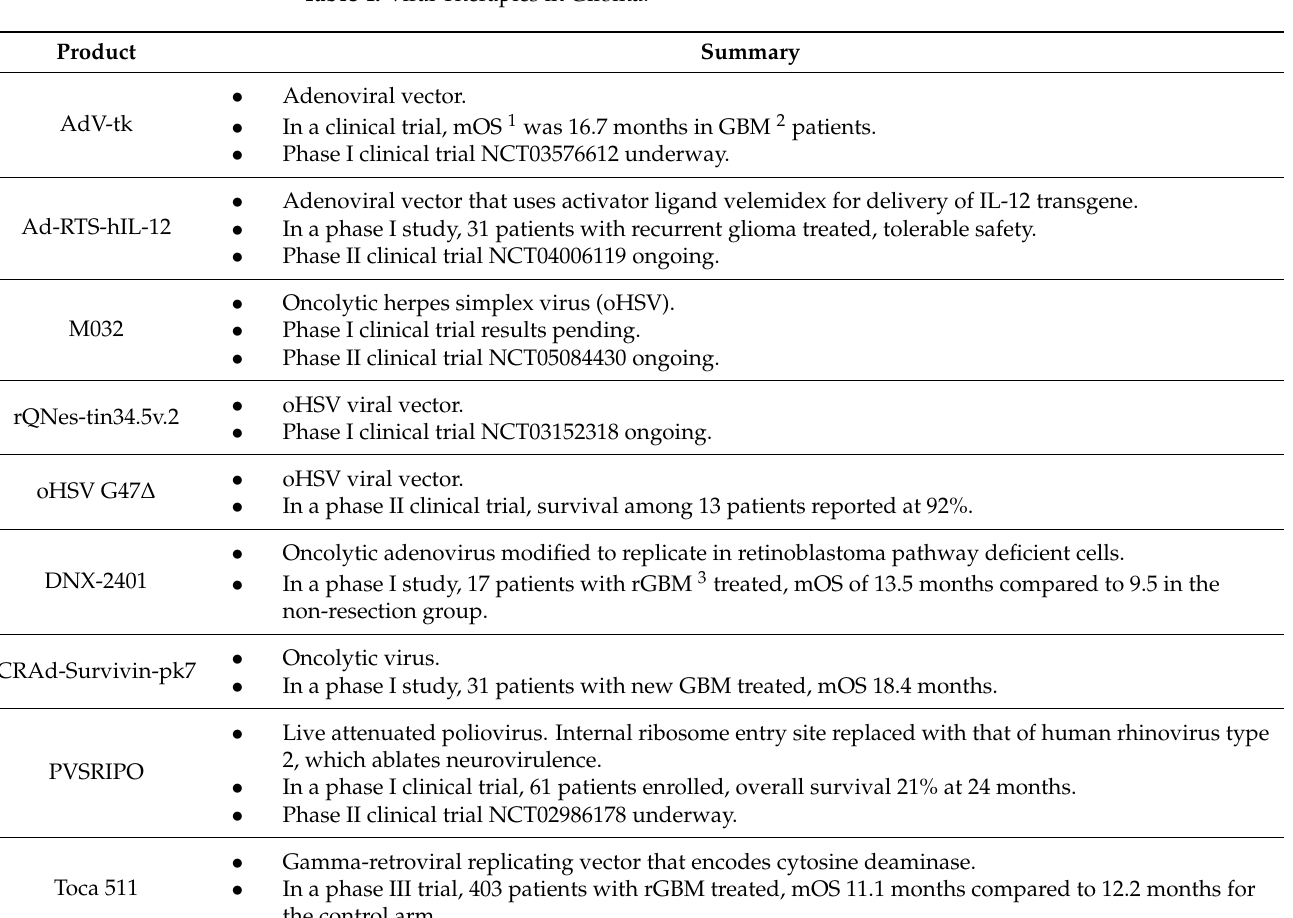
Table 4. Viral Therapies in